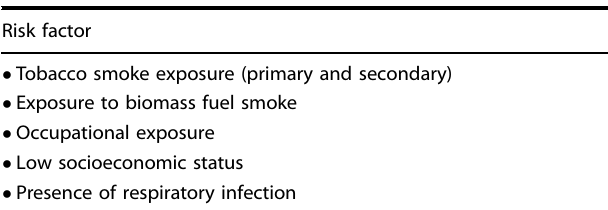
Table 1. Known risk factors for COPD in women 29 Risk